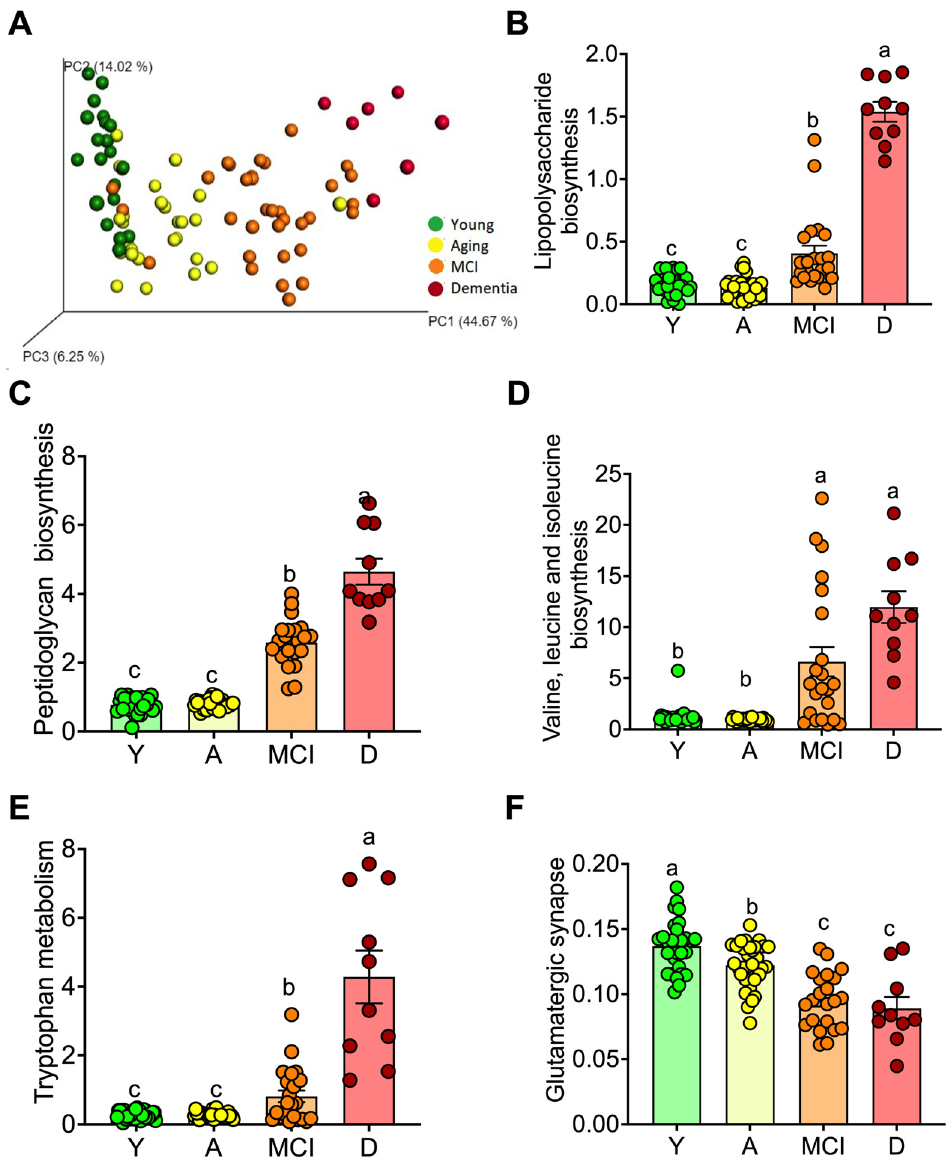
Figure 3. Predictive functional profiling of gut microbiota (Picrust) in young and aging adults. Principal component analysis of prediction of the functional profile of gut microbiota ( A ). Main metabolic pathways modified: lipopolysaccharide biosynthesis ( B ), peptidoglycan biosynthesis ( C ), branched amino acid biosynthesis ( D ), tryptophan metabolism ( E ), and glutamatergic synapse ( F ) in young, and in healthy aging subjects, aging subjects with mild cognitive impairment (MCI), and dementia (D). Raw data and mean are presented ± standard error. Y = young, A = aging, MCI = mild cognitive impairment, D = dementia, a > b > c, significance p <